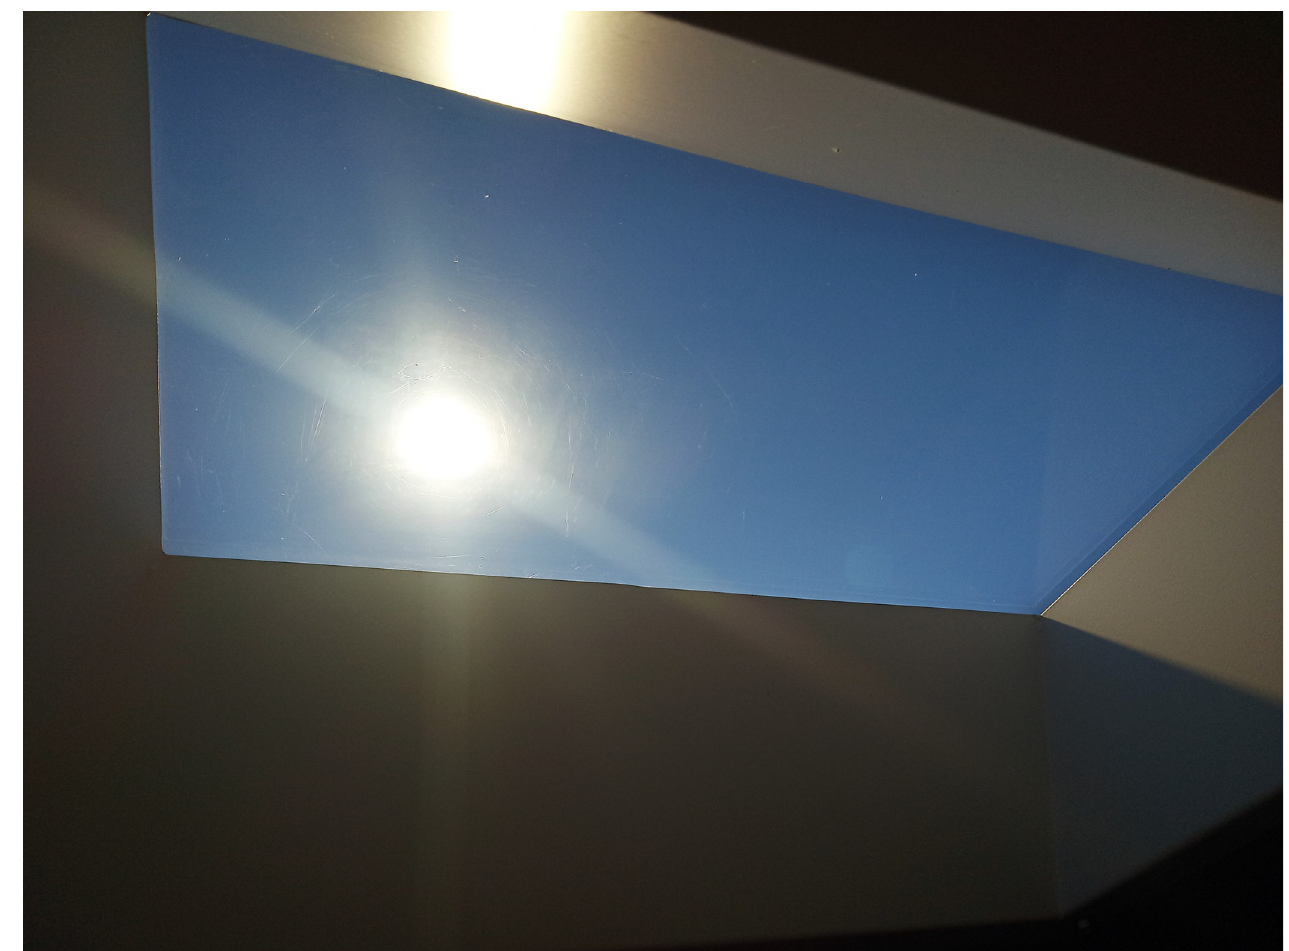
Fig 1. The visual appearance of the CoeLux 1 lighting system. The CoeLux 1 system is able to simulate the visual effect of the sun in a blue sky and project realistic shadows in the room, providing a real impression of natural sunlight together with all its properties.